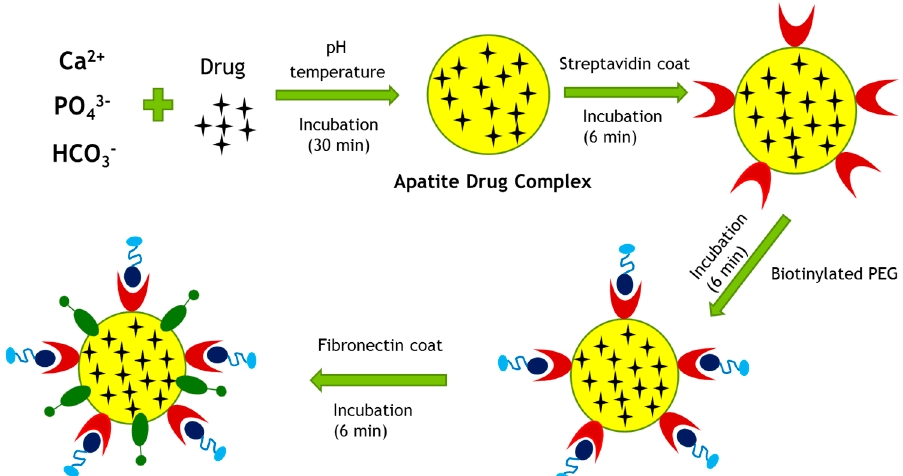
Figure 13. Fabrication of surface-modified, drug-loaded CA particles. The particles were fabricated by allowing interactions among the salts of Ca 2+ , inorganic phosphate and bicarbonate in DMEM with its pH adjusted to 7.4, and incubating the resulting mixture at 37 °C for 30 min. Once the apatite–drug complex were formed, streptavidin, biotinylated PEG and fibronectin were added sequentially, with 6 min incubation at 37 °C maintained for each of the steps.